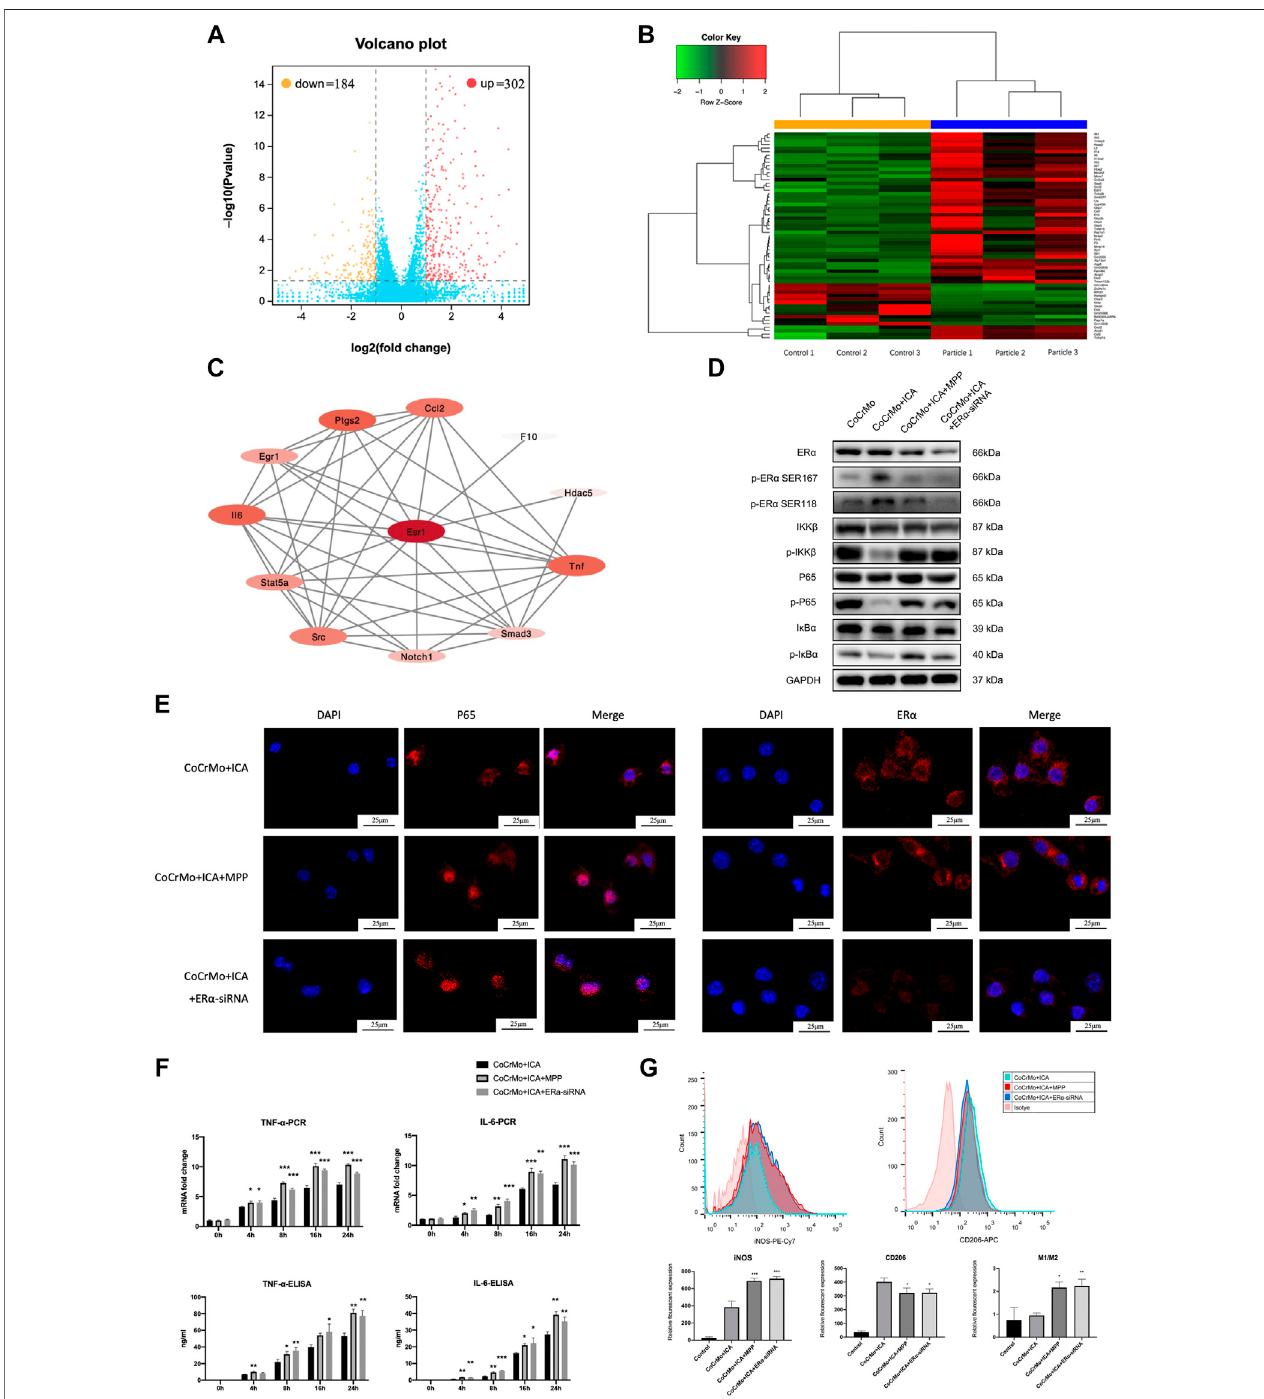
FIGURE4| TheinhibitoryeffectofICAontheCoCrMoparticle-inducedBMDMin fl ammatoryresponsewasmediatedbyER α . (A) Volcanoplotshowsatotalof302 upregulated mRNAs and 184 downregulated mRNAs in macrophages after stimulation by CoCrMo particles. (B) The heat map. (C) The PPI network from the STRING databaseshowedthatER α hasacloserelationshipwithTNF- α andIL-6. (D) TheinhibitoryeffectofICAonp-IKK β ,p-p65andp-I κ B α proteinexpressionwasblockedby ER α antagonist and by ER α -siRNA interference. (E) Confocal microscopy showing translocation of ER α from the cytoplasm into the nucleus after ICA treatment, whereas P65 translocation toward the nucleus was suppressed. (F) No signi fi cant differences in the mRNA transcription and protein secretion of TNF- α and IL-6 by BMDMs were found between the CoCrMo, CoCrMo + ICA + MPP, and CoCrMo + ICA + ER α -siRNA groups. (G) The effect of ICA on CoCrMo particle-induced macrophage M1 and M2 polarization was reversed by ER α antagonist and by ER α -siRNA interference. * indicates p < 0.05, ** indicates p < 0.01, and *** indicates p < 0.001.